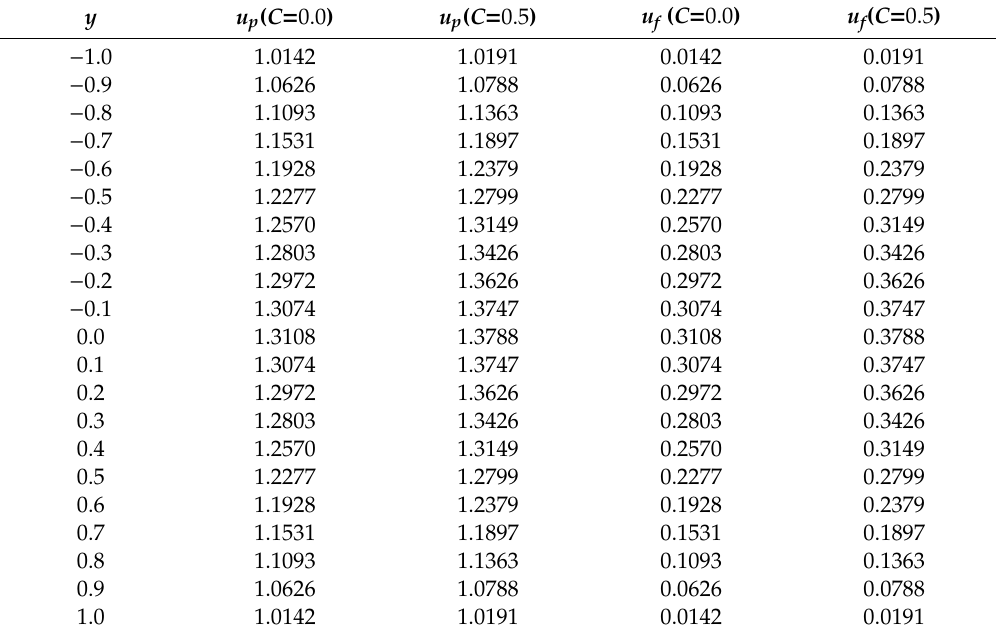
Table 2. Variation in the velocities for single- and two-phase flows at di ff erent